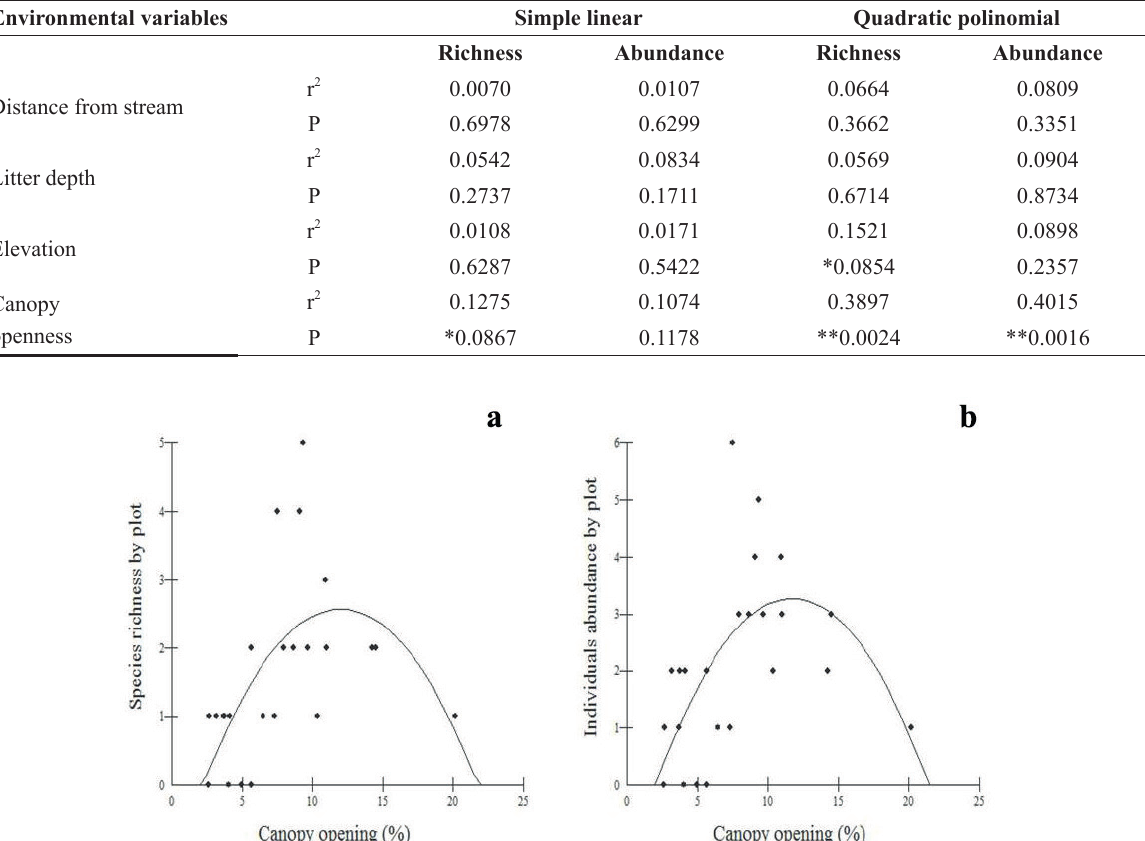
Results of simple linear regression and quadratic polynomial regression analyses between environmental variables (independent variables) and richness and abundance of the snake assemblage (dependent variables). *Marginally significant results; **Significant results.